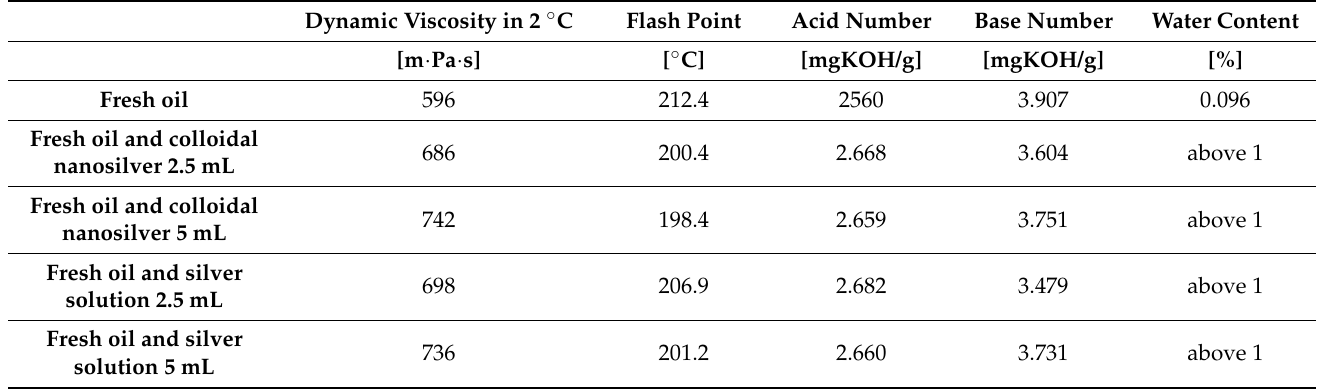
Table 3. Comparison of the parameters of fresh oil without additives with fresh oil with the addition of colloidal nanosilver and silver solution.